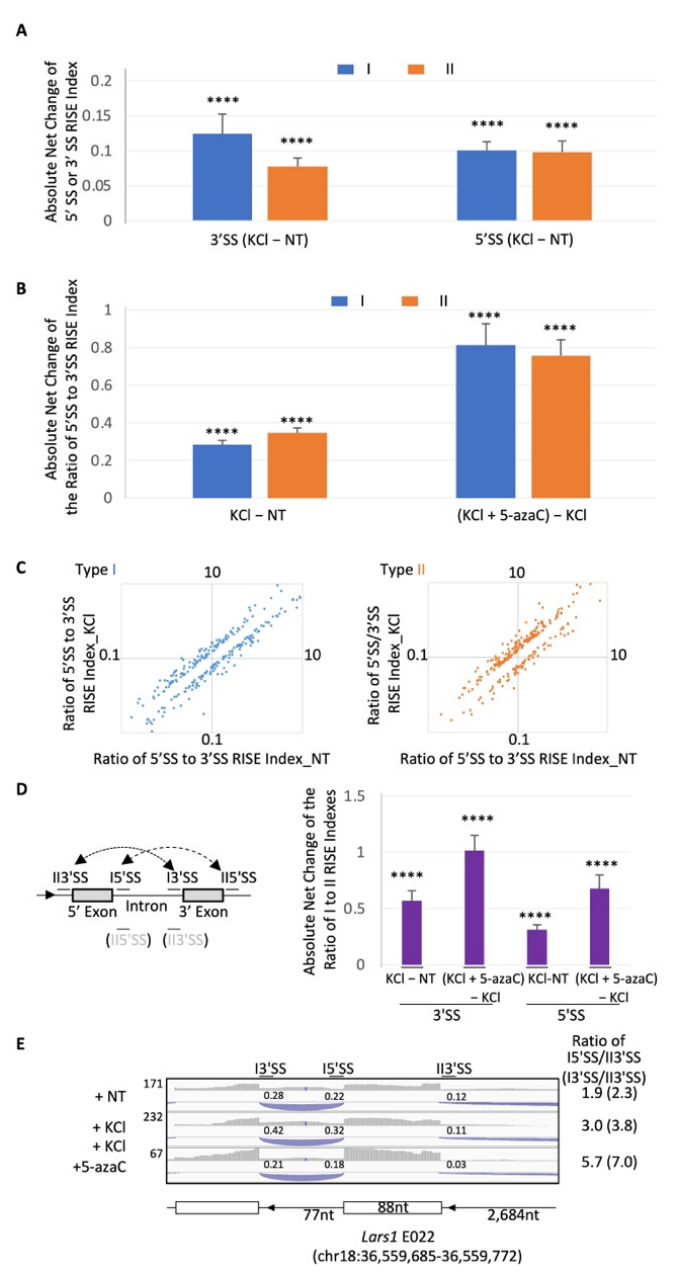
Figure 5. Global changes of the RISE indexes and 5 ′ SS/3 ′ SS RISE index ratios by depolarization. ( A ) Absolute net changes (Mean ± SEM) of the indexes of 5 ′ or 3 ′ SS RISE across introns (I, n = 803 pairs) or exons (II, n = 535 pairs) by KCl versus those in NT. ( B ) Absolute